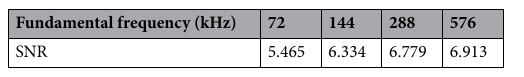
Table 3. Fundamental frequency and SNR.